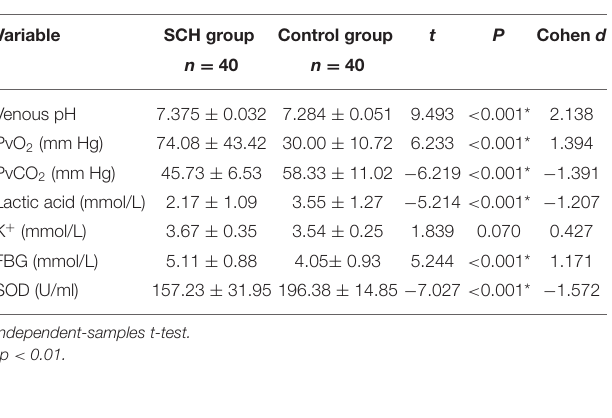
TABLE 2 | VBG analysis and SOD ( mean ± SD).